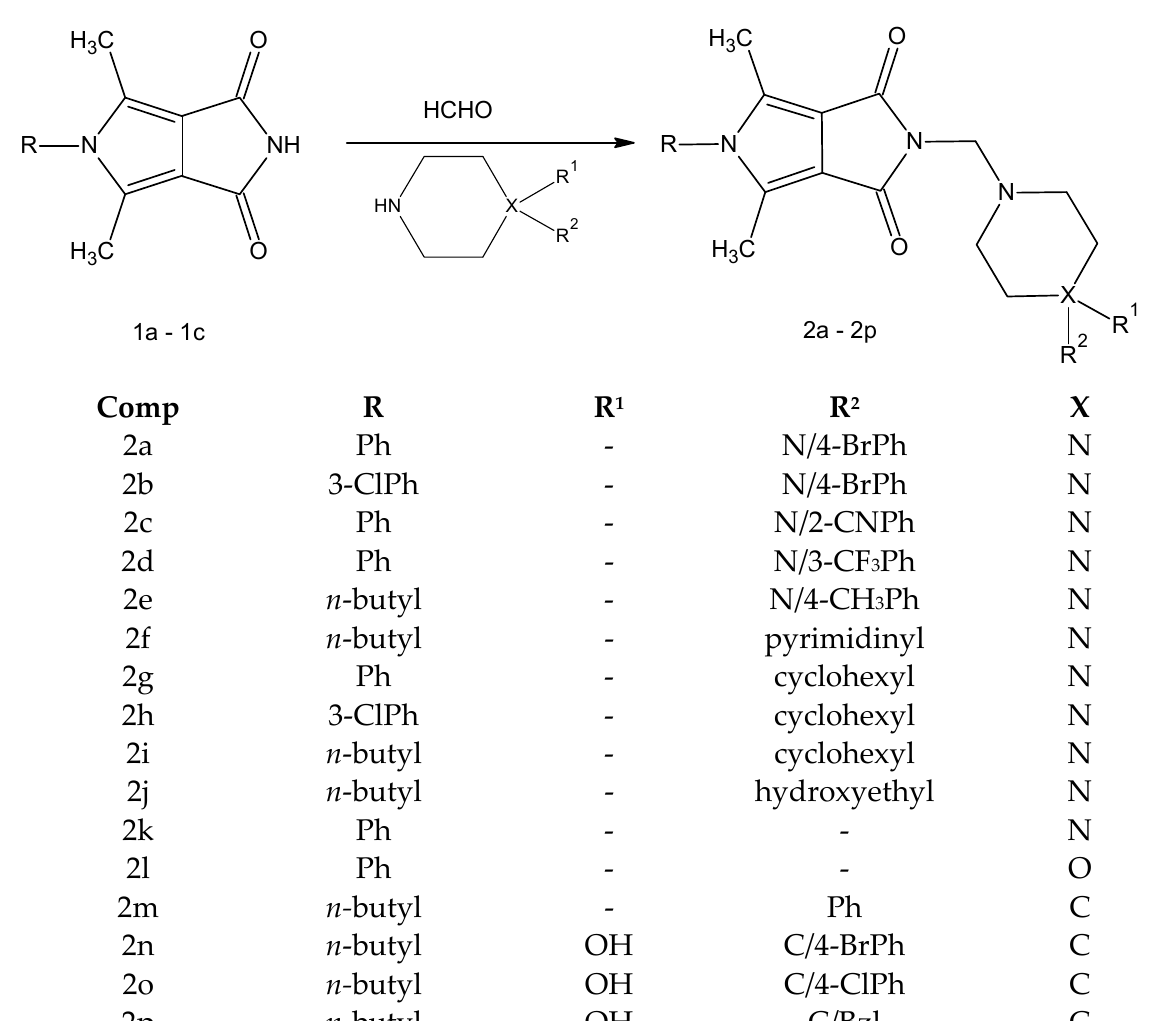
Scheme 1. Synthetic route of the target compounds 2a – 2p